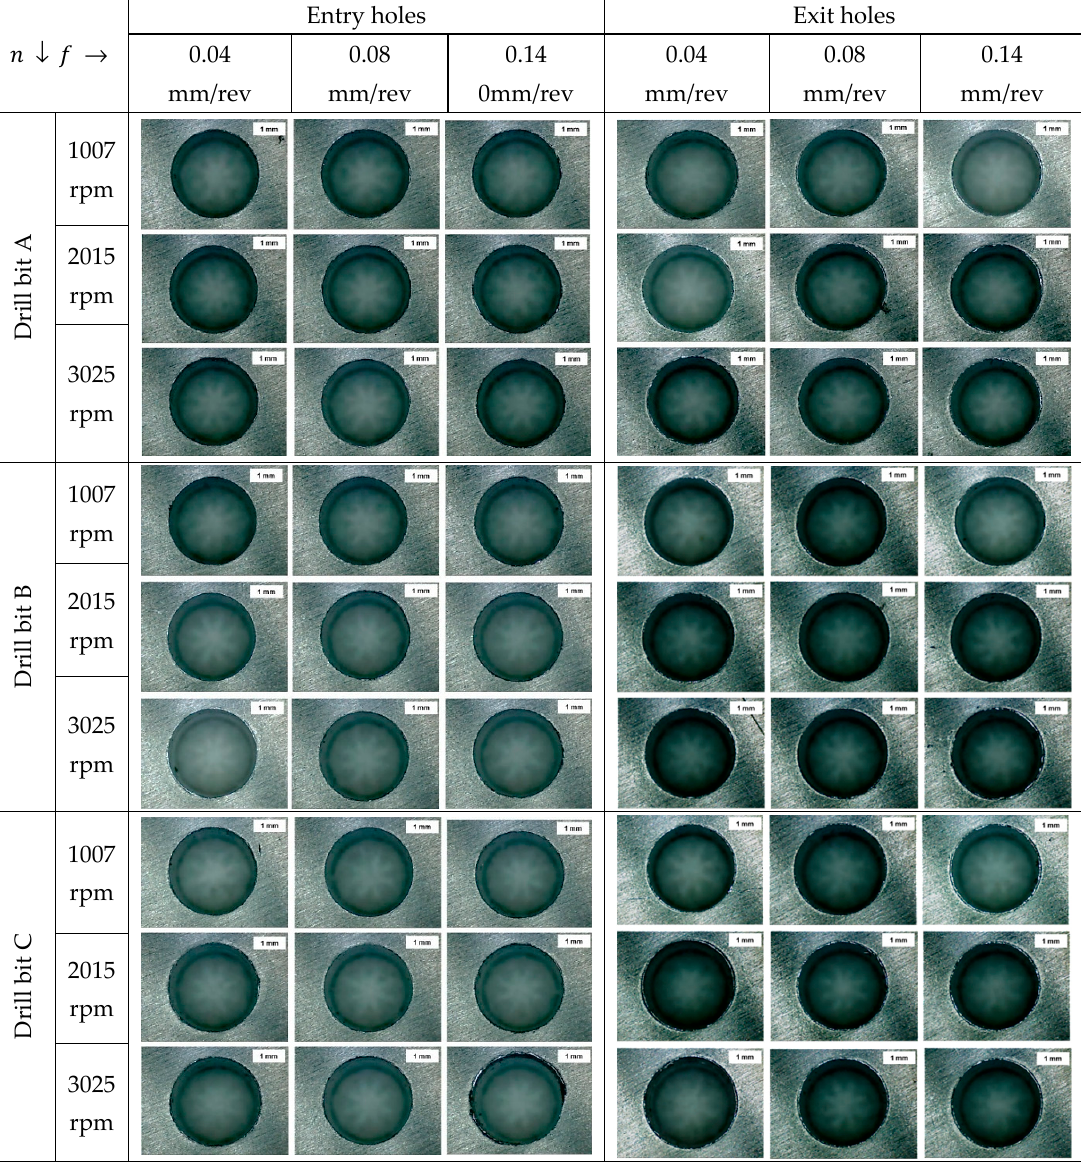
Figure 4. Hole images from TiN coated carbide drills.